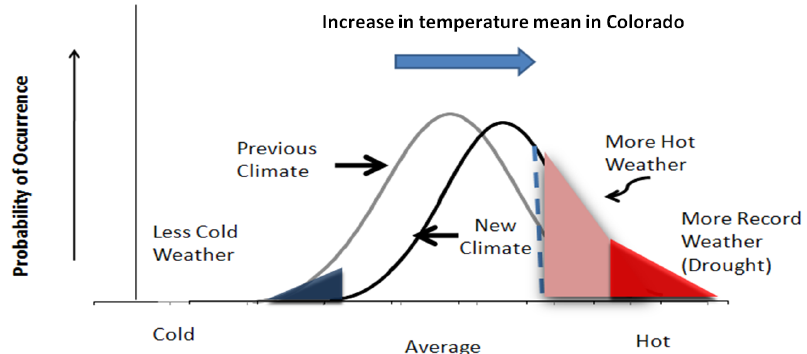
Figure 1. Climate change scenarios in Colorado Economic Displacement Mathematical Programming